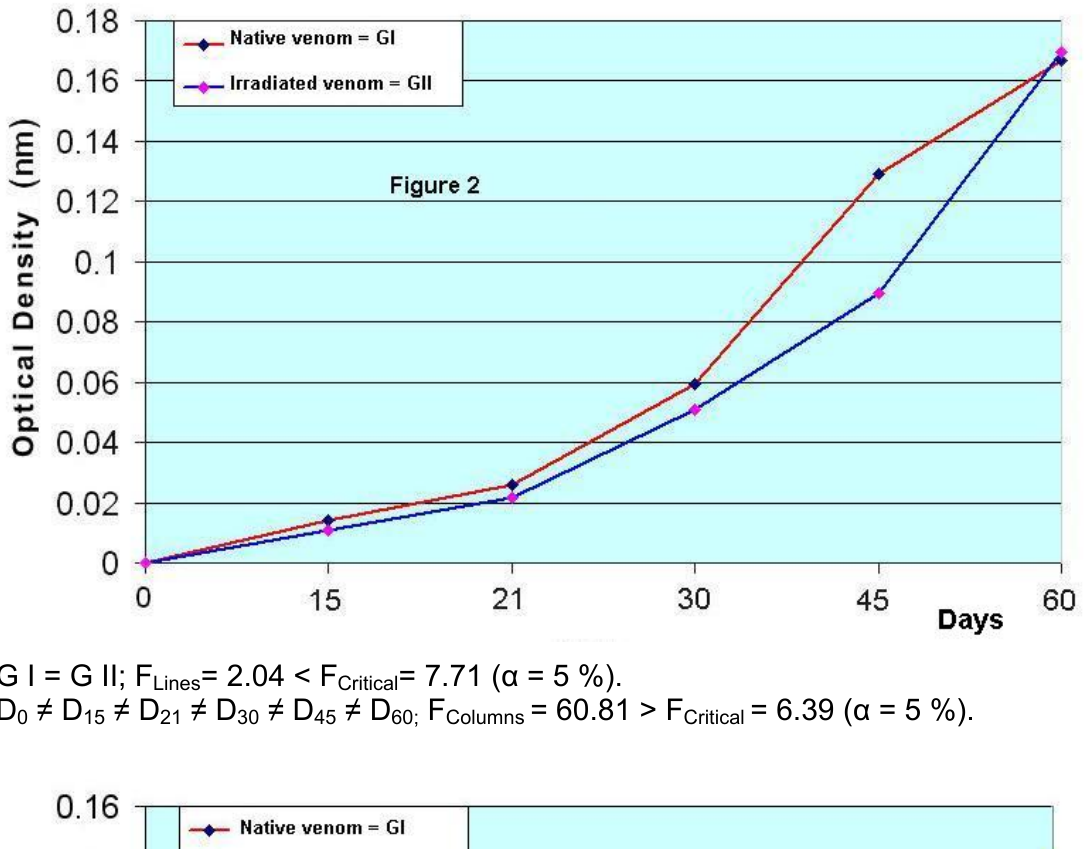
= 6.39 ( α = 5 %). Critical